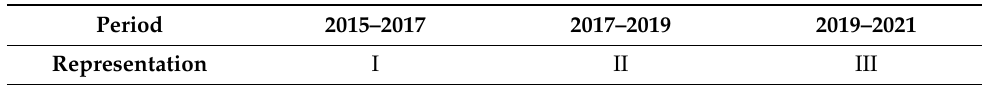
Table 6. Time series representation.